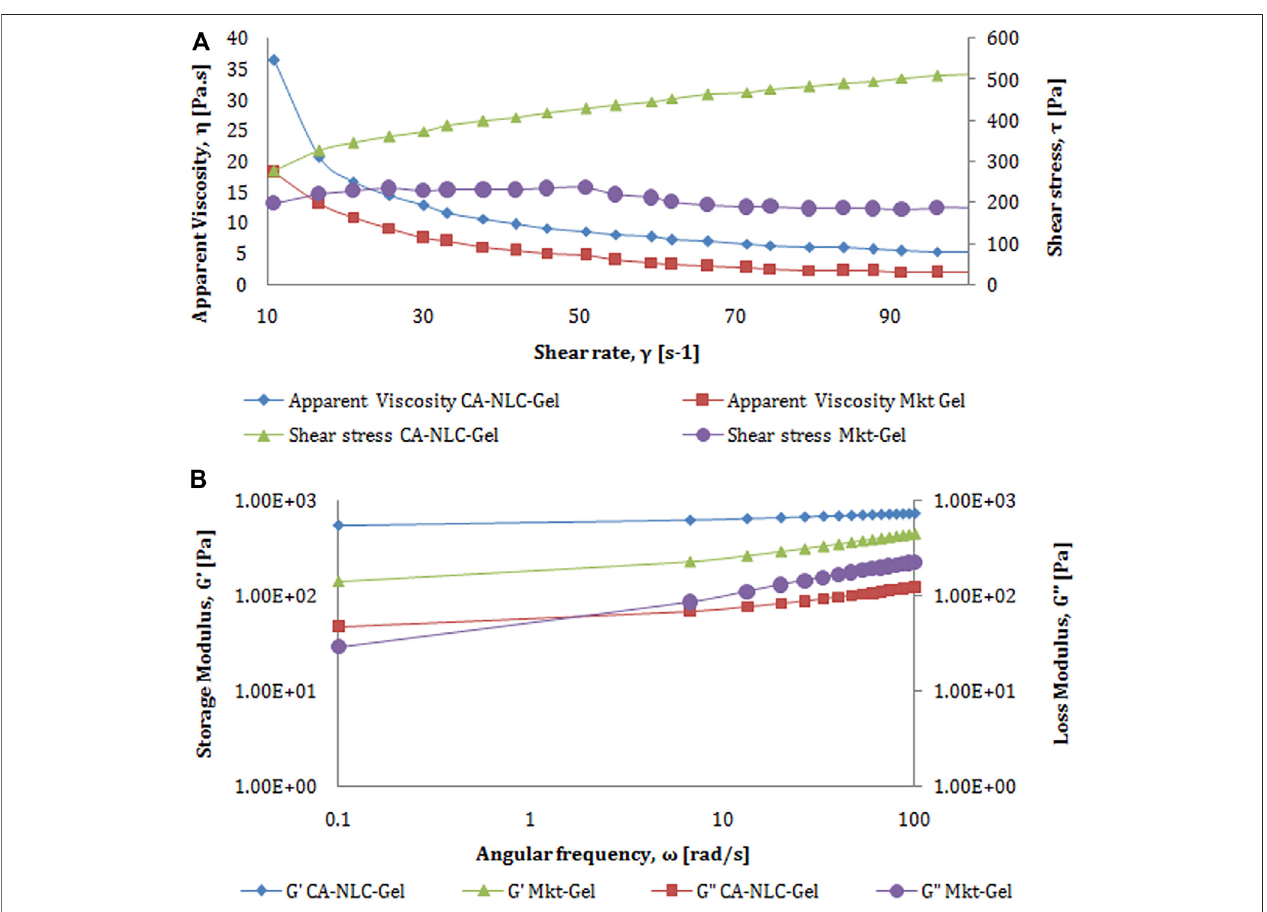
FIGURE4 | Characterization of rheology behaviorof developed CA-NLC-gel and Mkt-gel formulations withrespect to (A) shear rate vs. apparent viscosity and (B) angular frequency vs. storage modulus.